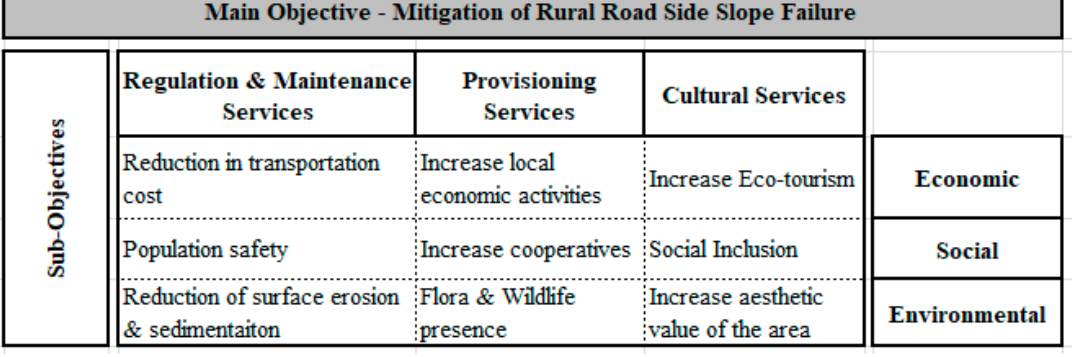
Figure 7. Example of main objective and associated sub-objectives of eco-engineering to be implemented along a rural road passing through cultivated land, settlement, and natural forest (modified from Calliari et al. (2019) [35] ).